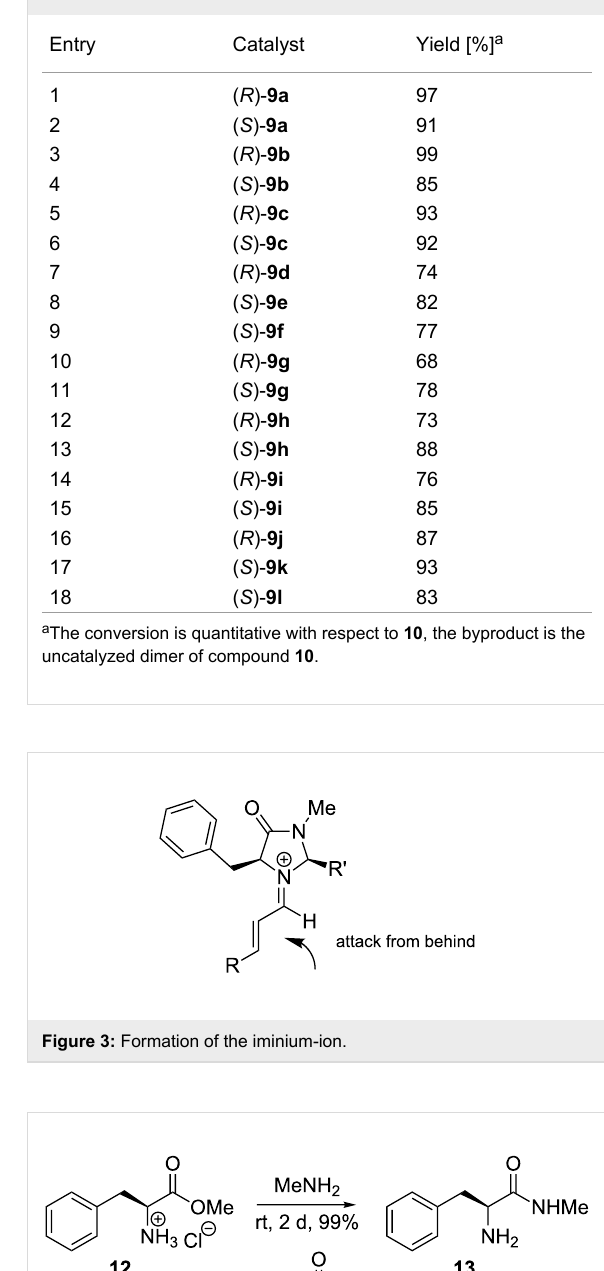
Table 1: Yields of thiourea syntheses. Table 2: Summarized results of the Diels–Alder reaction.